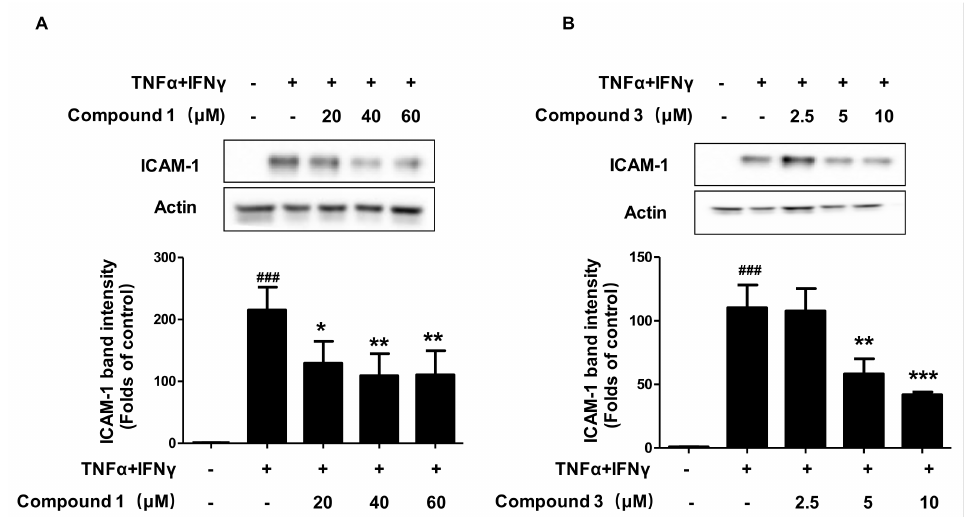
Figure 5. Effects of compounds 1 and 3 on TNF- α /IFN- γ induced ICAM-1 expression in HaCaT cells ( A , B ) The expression of ICAM-1 was measured using Western blotting. The cells were pretreated with the indicated concentrations of compounds 1 and 3 for 3 h (+) or not (-), and then stimulated with TNF- α /IFN- γ (+) for 24 h. Data are represented as the mean ± SD of three independent experiments.